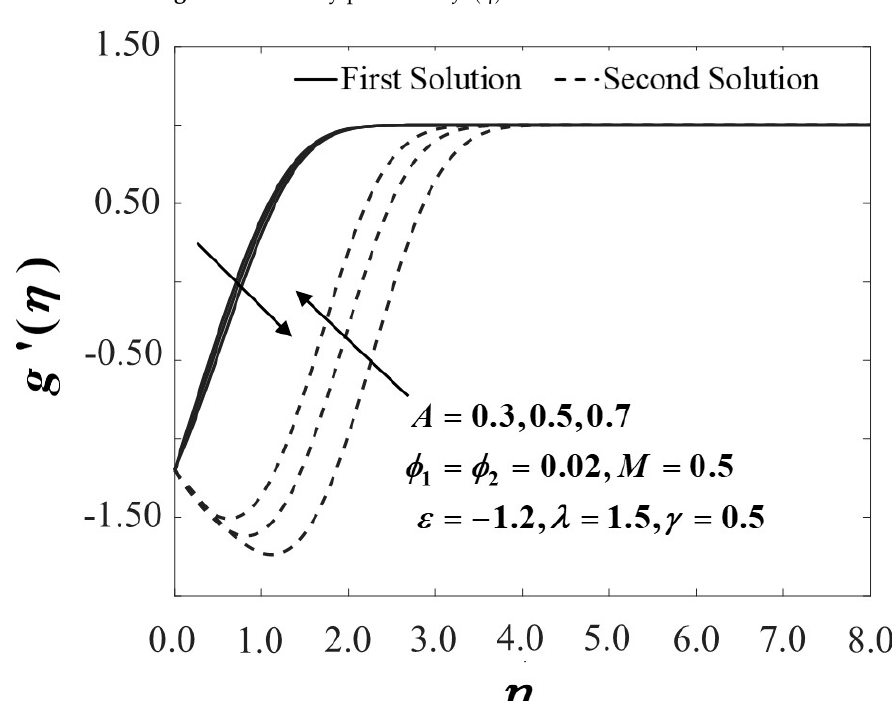
η′ for different values of A .